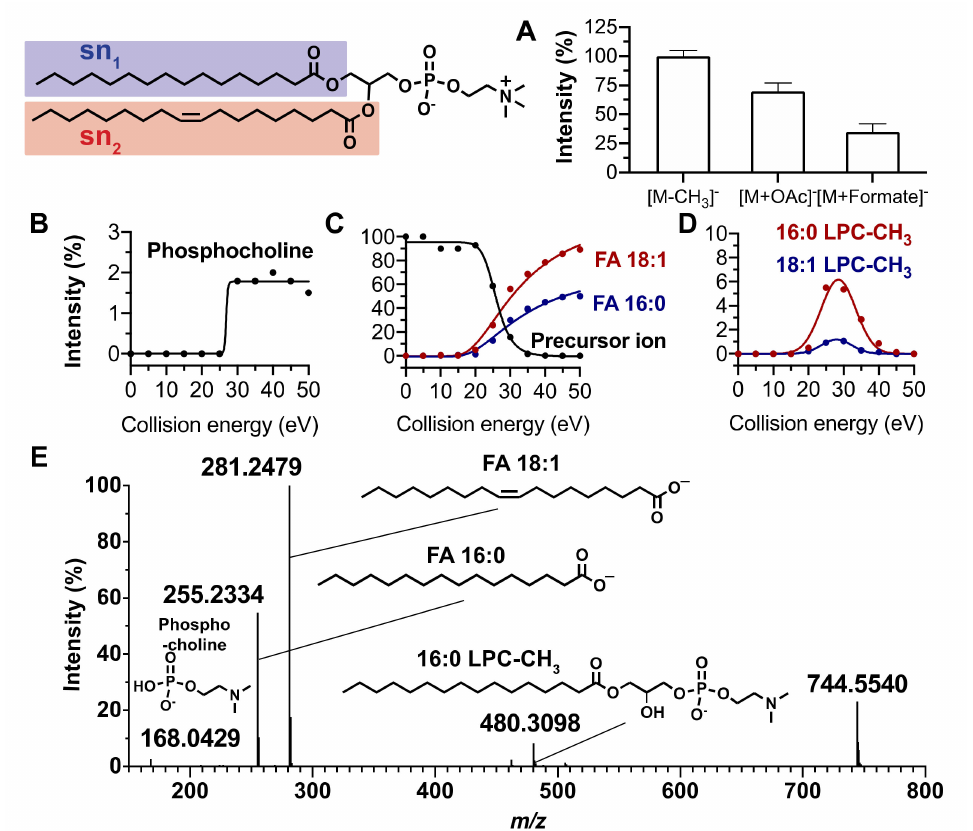
Figure 1. MS characteristics of PC (16:0 / 18:1). ( A ) Relative intensities of [M − CH 3 ] − , [M + OAc] − , and [M + HCOO] − ions. ( B – D ) Fragmentation patterns of the [M − CH 3 ] − ion formed from PC (16:0 / 18:1) under negative ionization conditions: relative intensities versus collision energy of ( B ) polar head group, ( C ) fatty acyl side chains, and ( D ) demethylated lysophosphatidylcholine ions. ( E ) Tandem mass spectrum of PC (16:0 / 18:1) [M − CH 3 ] − ion obtained by collision energy ramping from 20 to 40 eV. Blue and red colors relate to the sn 1 and sn 2 positions,